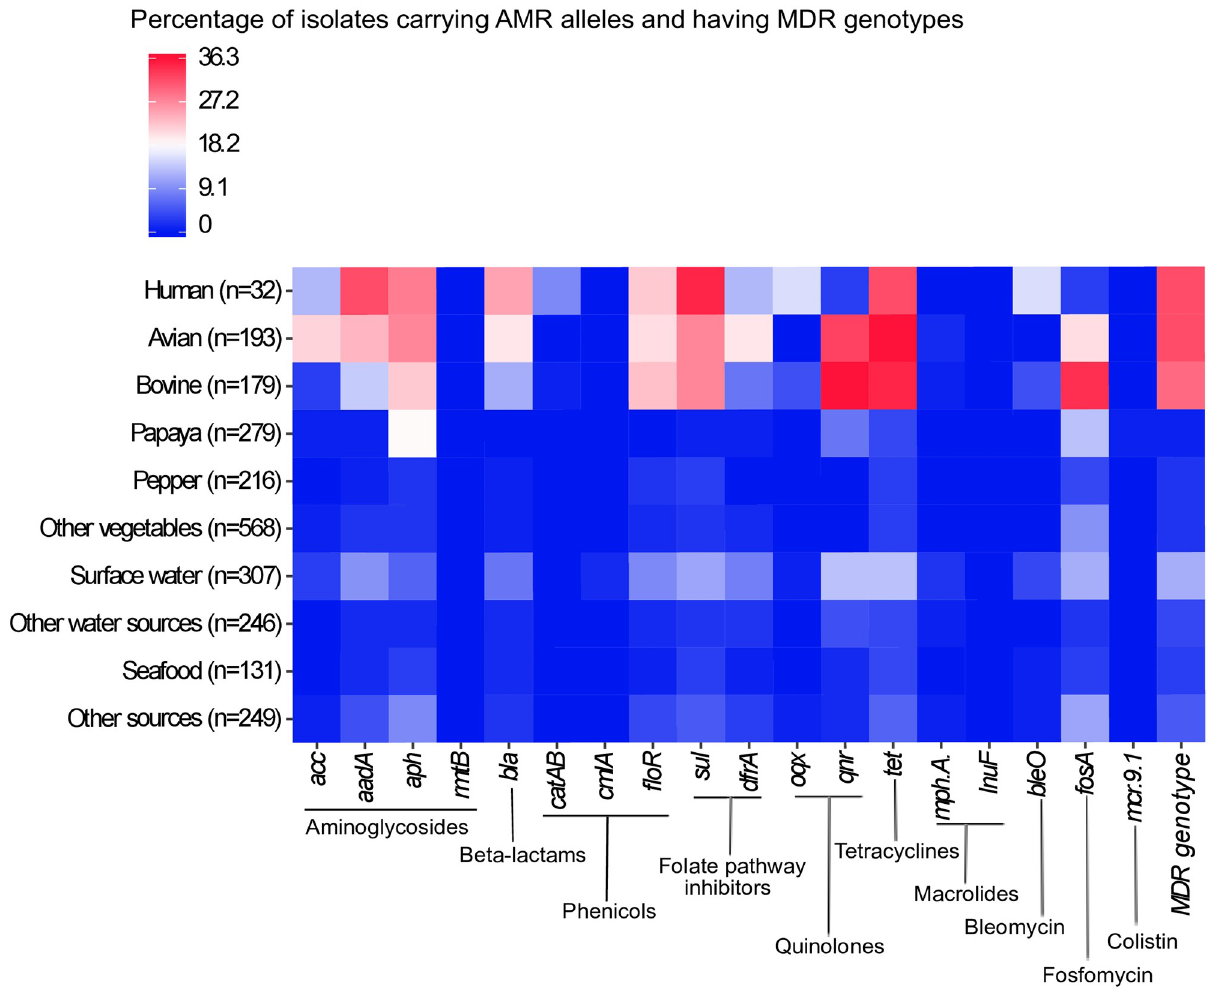
Fig 3. Heatmap showing the AMR profile of public NTS isolated from major sources in Mexico. AMR genes and the antibiotic class affected by them are indicated on the bottom. Refer to S2 File for accessions and metadata of isolates included in this analysis.